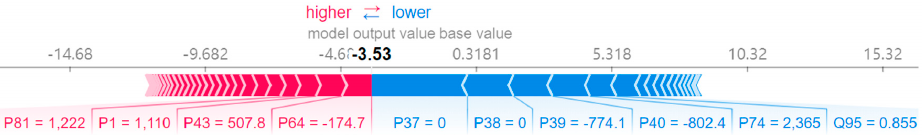
Figure 8. Interpretability of a prediction produced by AutoML on the Yunnan.